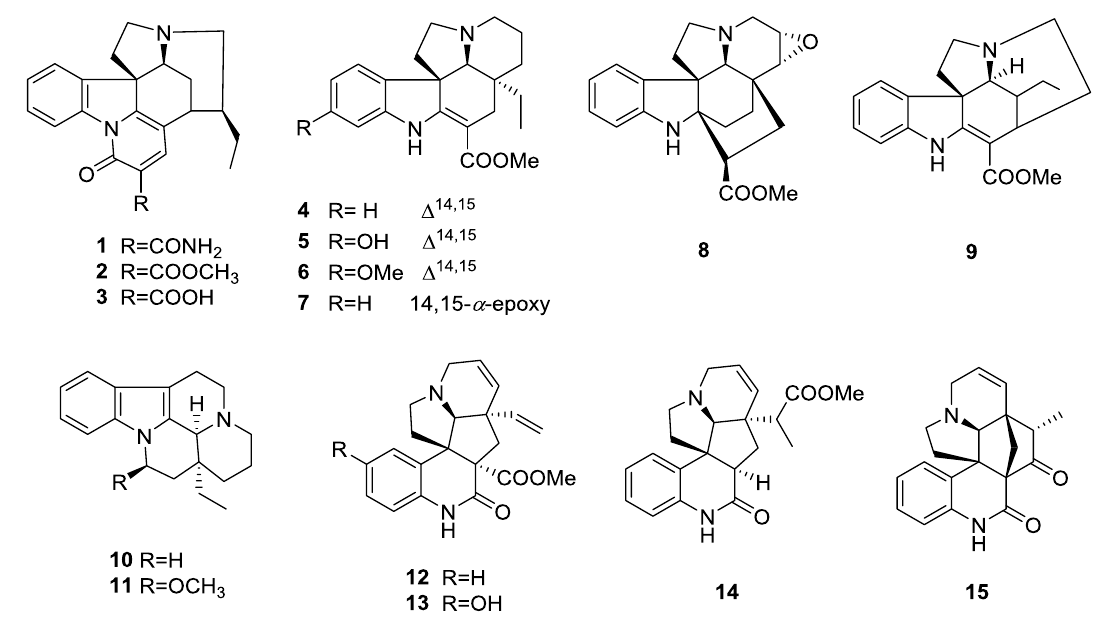
Fig. 4 Chemical structures of compounds 1 –